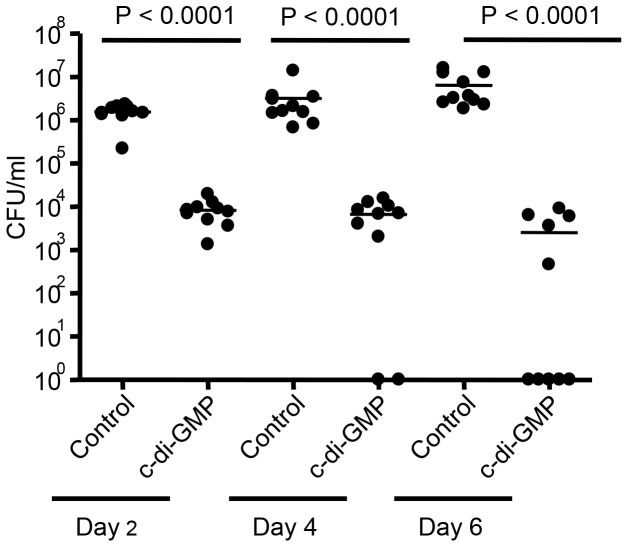
Pretreatment with c-di-GMP reduces the bacterial load in the lungs of mice challenged with B. pertussis.Mice were intranasally treated with c-di-GMP or control (PBS) at 24 hr prior to challenge. Bacterial counts were determined at day 2, 4 and 6 post challenge. The results are expressed as the mean values ± the standard deviations per lung, as counted from individual lungs of 10 mice per group from three separate experiments. *, P<0.0001 in lung homogenates versus the control group.